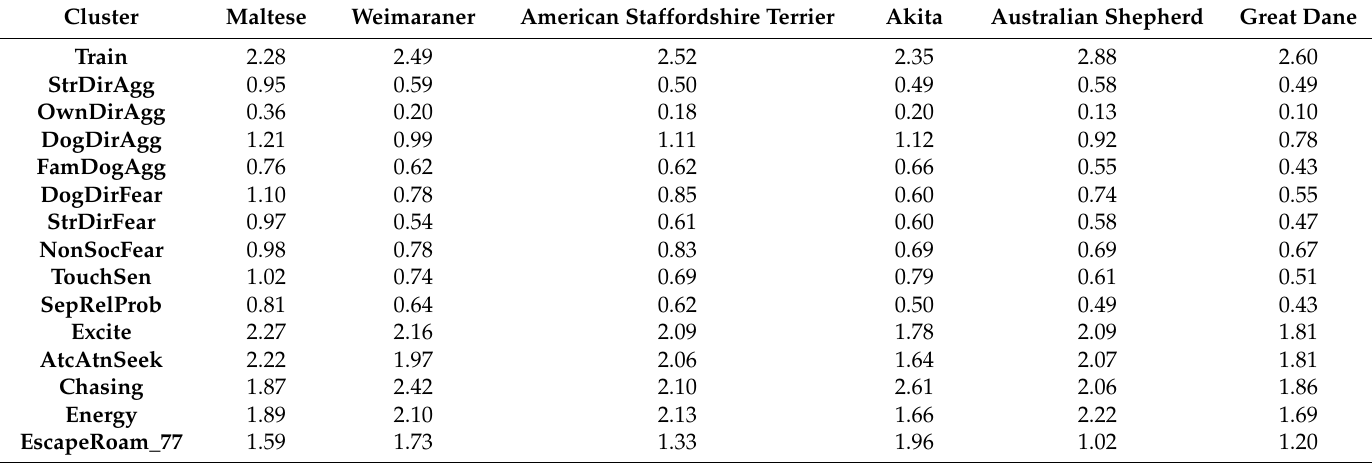
Table 4. Cluster average C-BARQ scores for behavioural subscales (ordered from left to right by median cluster height).